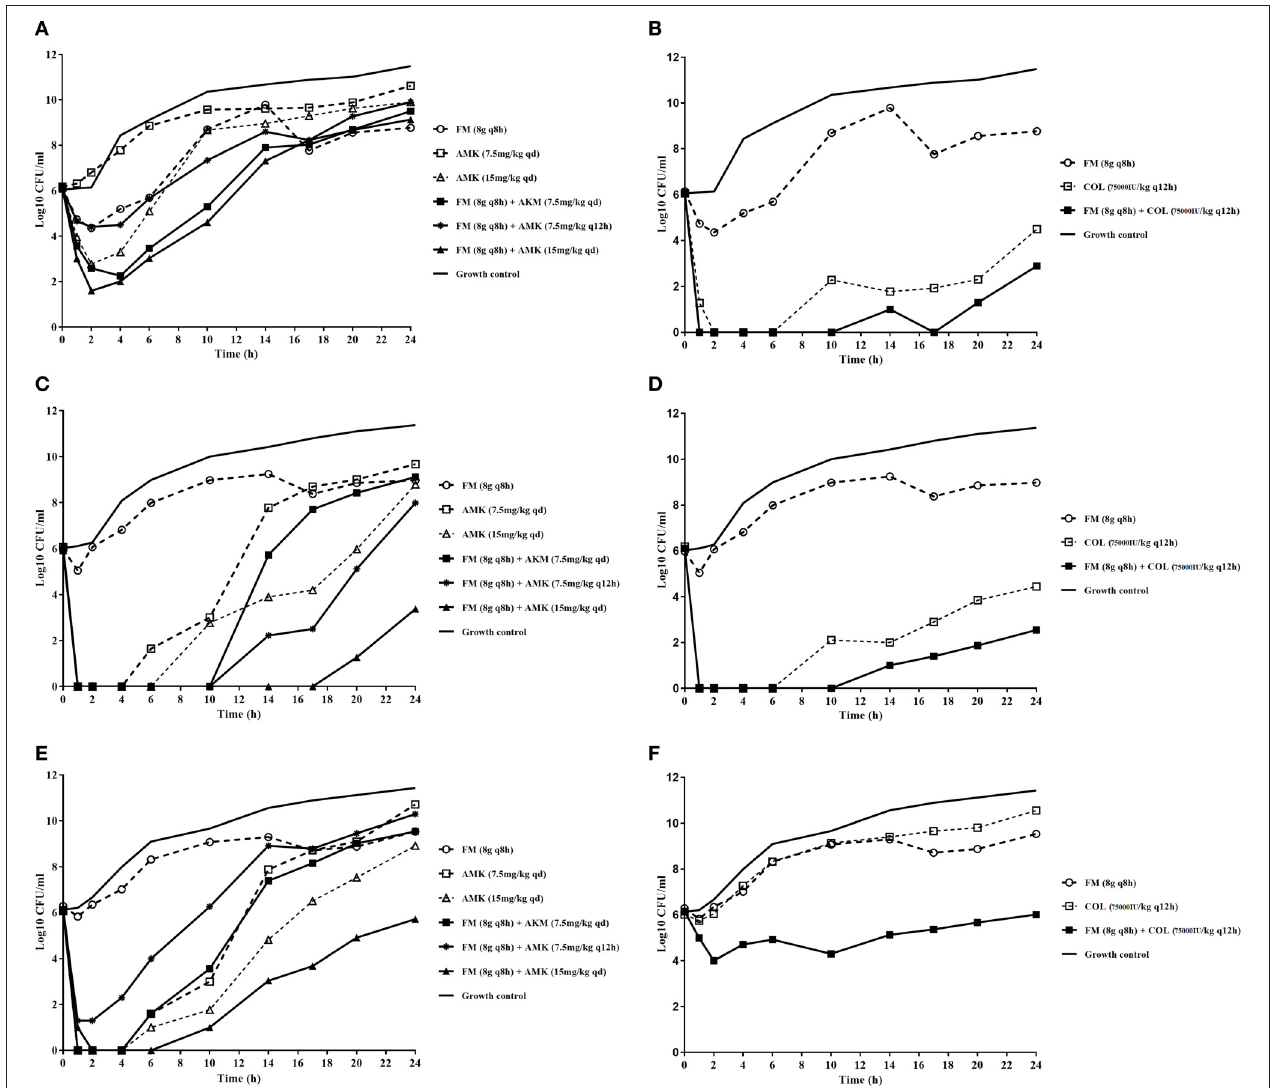
FIGURE 1 | In vitro dynamic model time-kill assays using concentrations of fosfomycin, amikacin, and colistin (either alone or in combination) against three KPC-producing K. pneumoniae strains. (A) and (B) mono or combination therapy, respectively, against isolate ATCC BAA-1705; (C) and (D) mono or combination therapy, respectively, against isolate 17186; (E) and (F) mono- and combination therapy, respectively, against isolate 18253. FM, fosfomycin; AMK, amikacin; COL, colistin. The dotted lines indicate monotherapy, and the solid lines indicate combination therapy. Antibiotic concentrations are denoted by different